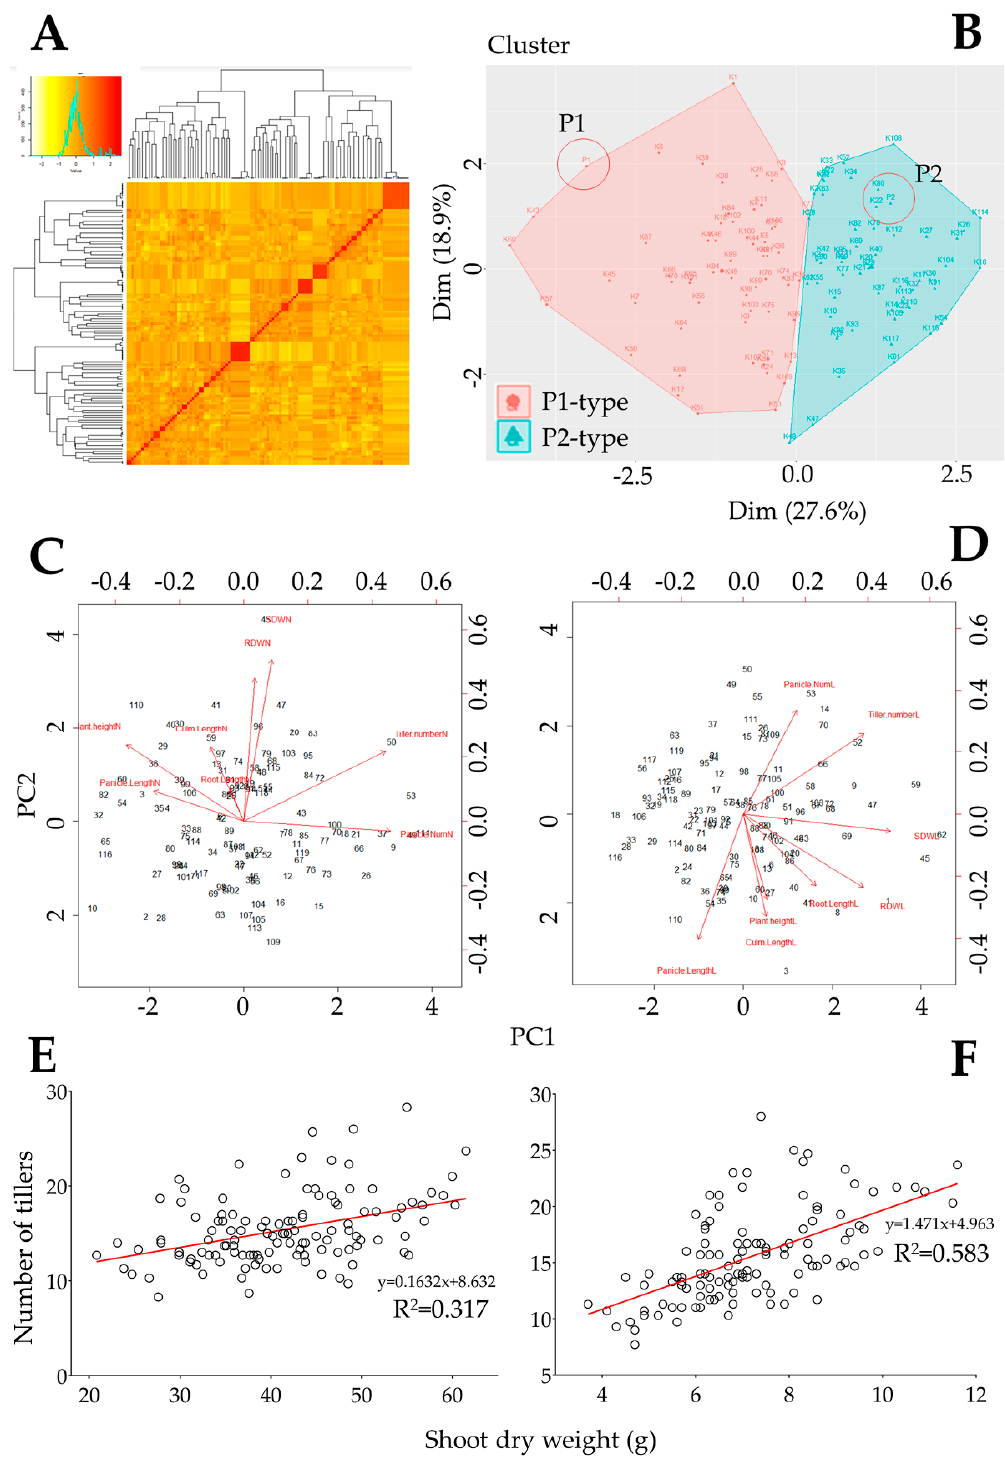
Figure 3. Population genome background and principal component analysis results. ( A ) The density map of pairwise kinship matrix values generated based on 240 KASP markers on a DH population, ( B ) cluster plot showing the distinctive phenotypic response between P1 (93-11) and P2 (Milyang352) based on the number of tillers under low N cultivation, ( C , D ) 2D principal component analysis (PCA) indicating the relationship between traits, and ( E , F ) linear regression analysis proposing the existence of a positive correlation between number of tillers and shoot dry weight in rice grown under a normal and low N cultivation regime, respectively.